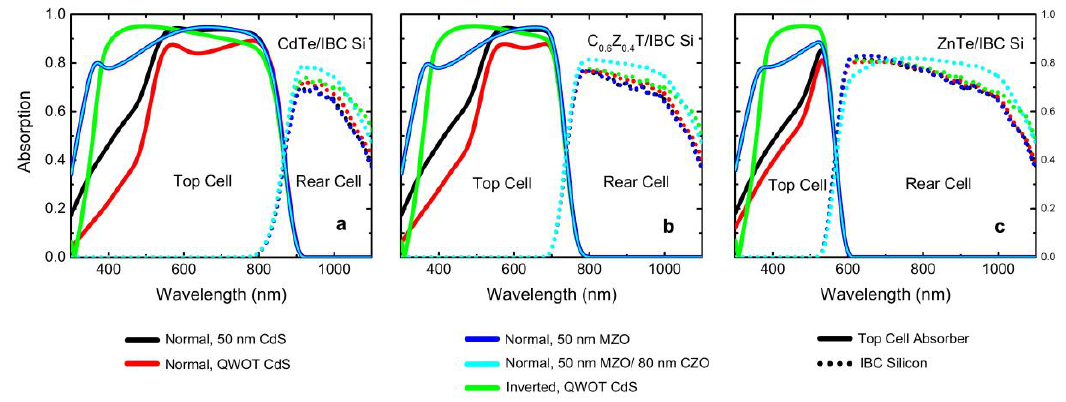
Figure 6. Absorption spectra of CdTe ( a ), C 0.6 Z 0.4 T ( b ), and ZnTe ( c ) top cells (solid lines), along with the corresponding IBC Si rear cell absorption spectra (dotted lines); in the normal configuration with 50 nm CdS (black), QWOT CdS (red), 50 nm MZO (blue), 50 nm MZO, and 80 nm CZO as rear TCO (cyan) and in the inverted configuration with QWOT CdS (green). In all cases, C 1 − x Z x T = 3 µ m, MoO x = 5 nm, front ITO = 55 nm, and rear TCO (ITO or CZO) = 100 nm. QWOT CdS values are 105 nm for CdTe, 95 nm for C 0.6 Z 0.4 T, and 65 nm for ZnTe top cells. Table 1. The MAPC (mA / cm 2 ) of the top and rear cells for the optimized normal design, with CdS and Mg 0.23 Zn 0.77 O ETL window layers, and the ITO and CZO rear TCO layers and the proposed